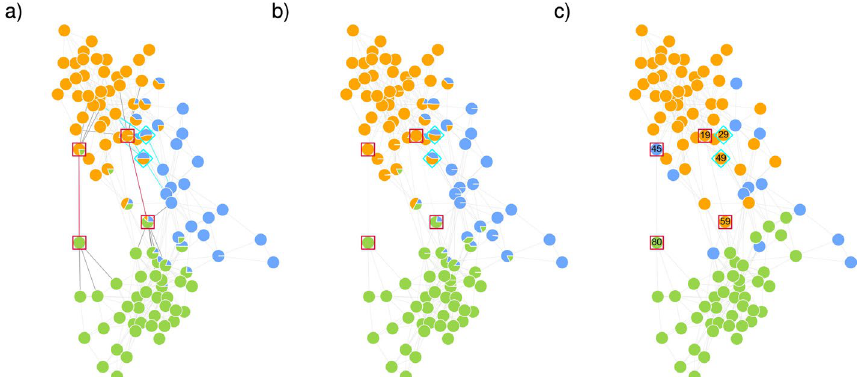
Fig. 10 The network of POLBOOKS (Experiment 2). a Soft community membership of nodes inferred by ACD. The edges inferred by ACD as anomalous edges are shown in red. Here, π = 0.0001, µ = 0.5 . b The communities inferred by CD, after removing the edges inferred as anomalous. c Ground truth communities. Red rectangles denote pairs of nodes that are connected by the edges inferred as anomalous. Cyan rectangles demonstrate the nodes that changed their community membership, after removing the aforementioned anomalous edges. Cyan edges in panel ( a ) present the edges connected to